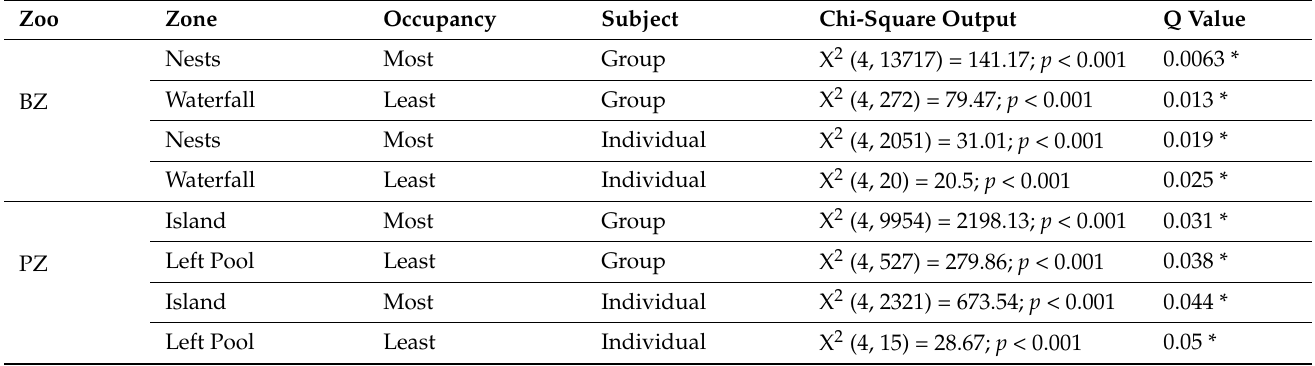
Table 2. Significant differences (marked with *) in overall zone occupancy (across all time periods) for individual and group data for least and most occupied zones at each zoo. Multiple p values compared to a Benjamini and Hochberg correction